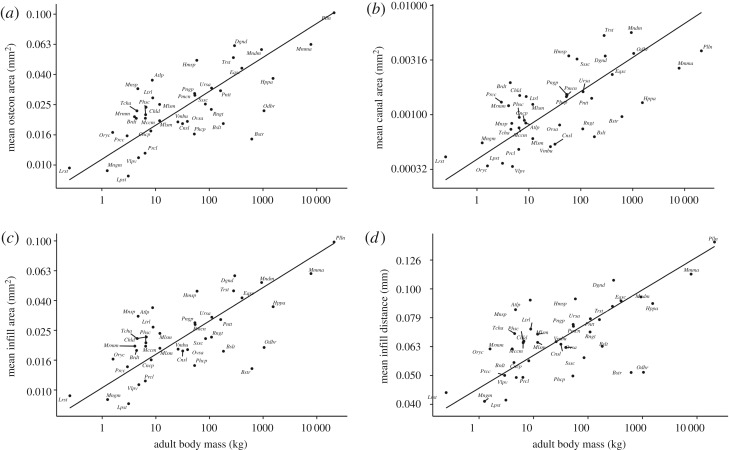
Log–log plots of per species means of the secondary osteon cross-sectional parameters and estimated body mass, where we found a significant relationship (R2>0.3, p<0.005). Estimates, sample square correlation coefficients and p-values for all parameters we measured can be found in table 3 and 4.